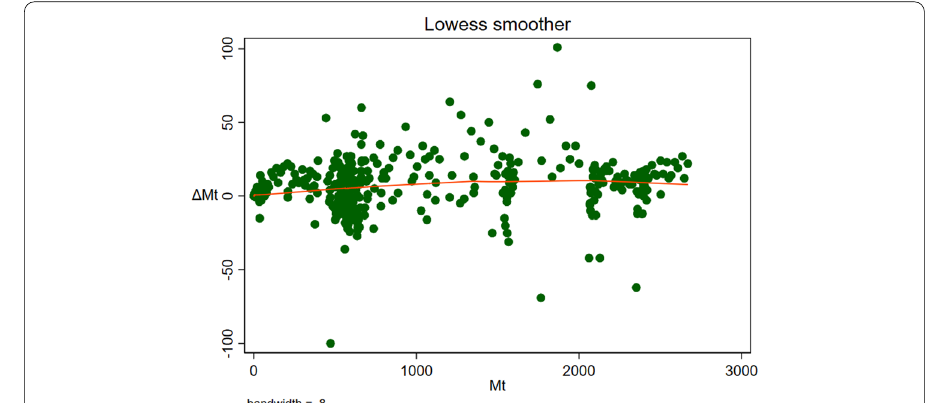
Fig. 3 Lowess smoother graph regressing the number of cryptocurrencies ( M t ) on the change of the number of cryptocurrencies ( (cid:31) M t ). Source : Own estimations